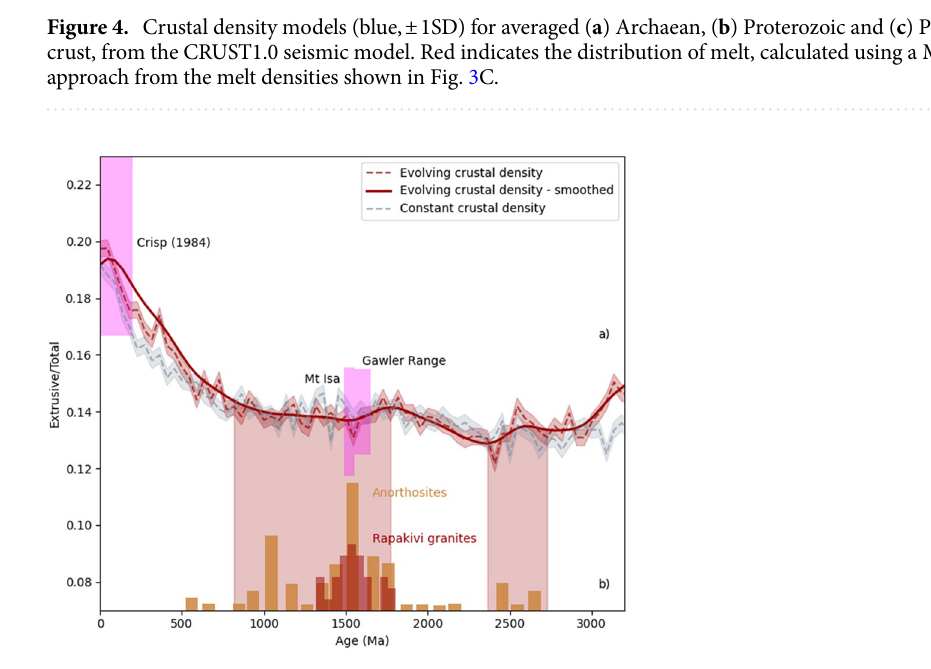
Figure 5. ( a ) Evolution of extrusive to total magmatism through time (E/T ratio), calculated for an evolving crustal profile (red) and for the case where the crustal density profile does not change (a constant Proterozoic profile) and only the mantle-derived melt densities change with time (teal). The latter isolates the effects of mantle-temperatures alone. Uncertainties are shown by shading, and a polynomial fit by the dark line, indicating two minima at ca 800–1800 Ma, and ca. 2300–2700 Ma. ( b ) Distribution of anorthosites 15 and Rapakivi granites 49 peaking in the Mesoproterozoic, similar to a low in the E/T ratio. A minimum in the E/T ratio occurs across the Proterozoic–Archaean boundary corresponding to the limited number of late-Archaean/ early Proterozoic massif-type anorthosites. Magenta regions show the E/T ratio for intraplate volcanic systems from White et al. 29 on the left, and those calculated here for the Gawler Range Volcanics and Mt Isa based on geophysical